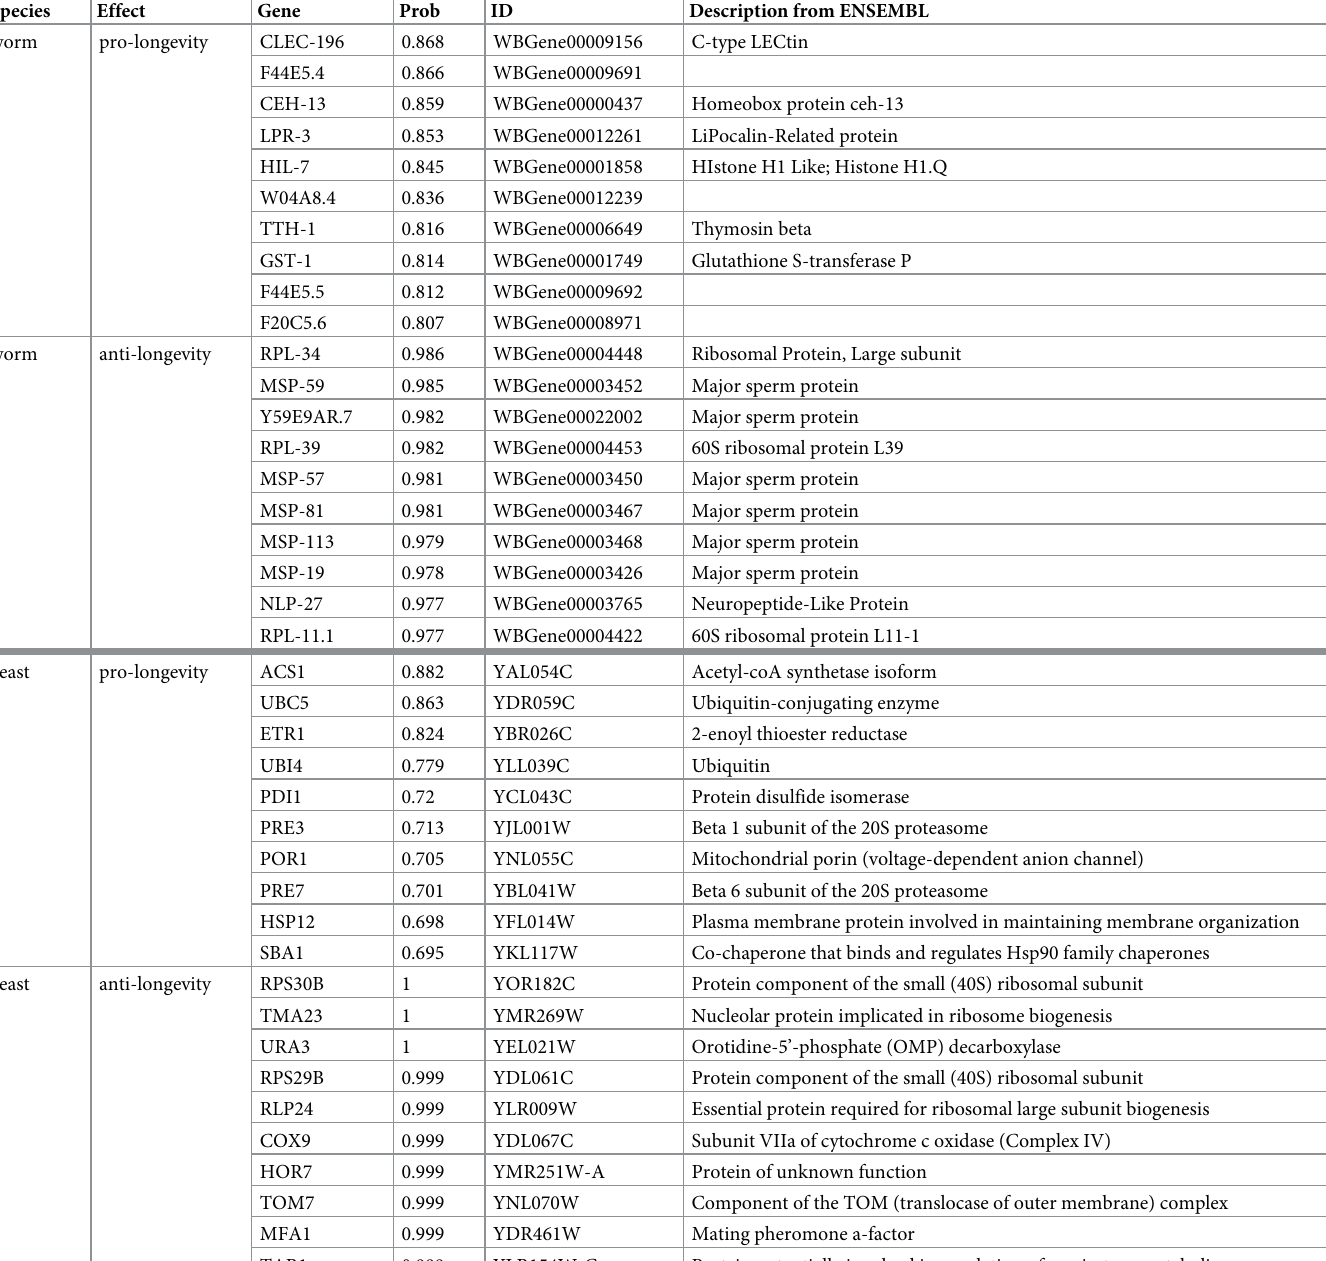
Table 1. Top pro-longevity and anti-longevity genes not in GenAge predicted using GO terms and ARCHS4 gene expression for worm and yeast with the pglm (GLM-Net) algorithm.